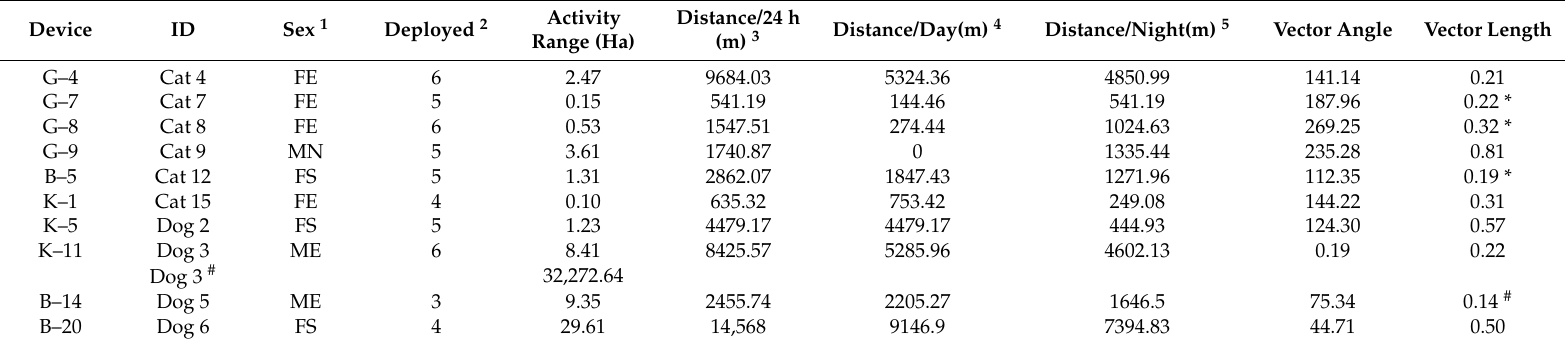
Table A2. This Table shows the ID, demographics, device deployment length, accumulated distance travelled and vector angle and length for each animal with an igot-U GPS logger attached to their